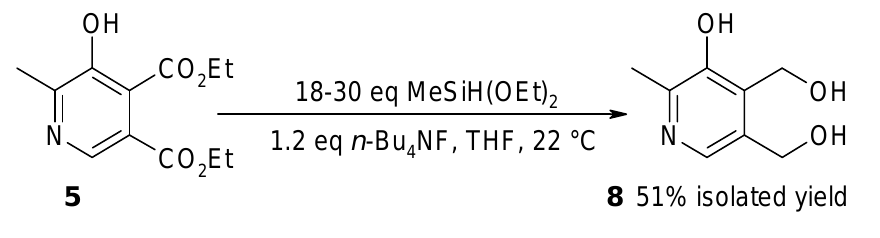
Figure 1: Some partially reduced Vitamin B